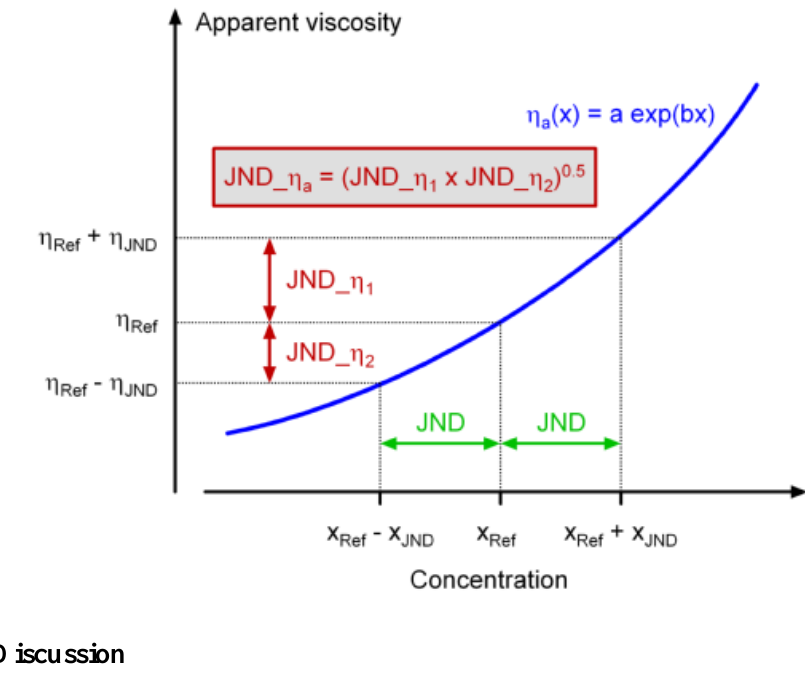
Figure 1. Schematic representation of the method for the calculation of just noticeable differences for viscosity (JND_η a